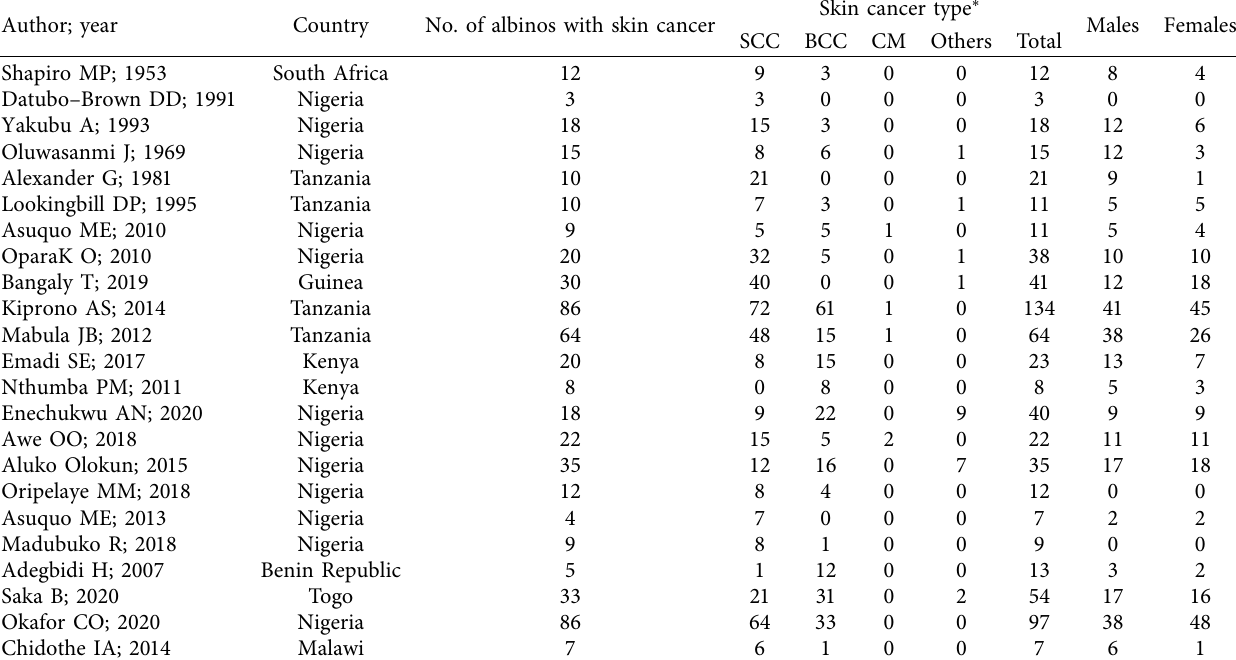
Table 2: Included studies, country of study, number of albinos, and skin cancer type.